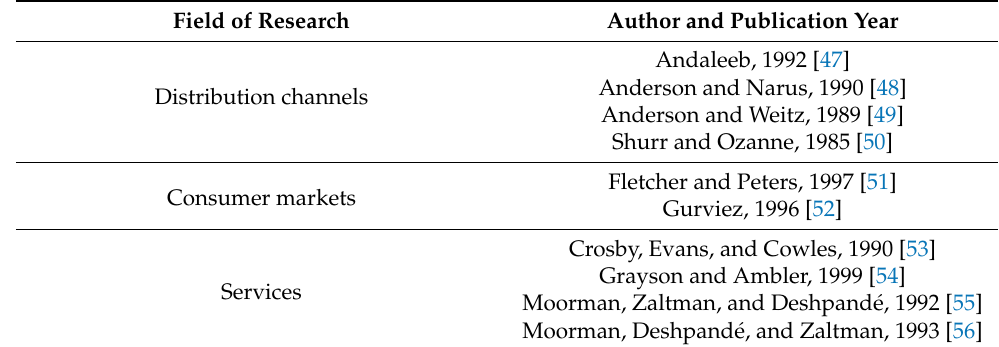
Table 1. Customer satisfaction research—comparative